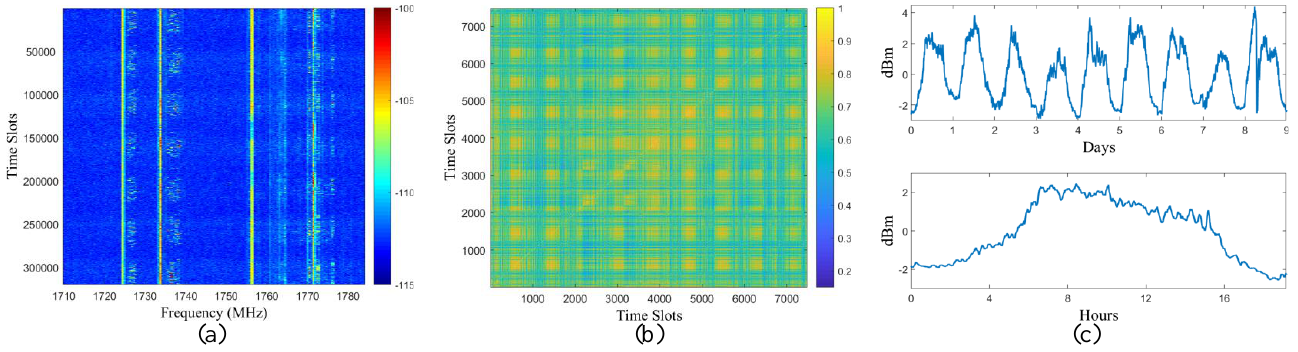
Figure 1. Periodic analysis of GSM1800 Uplink: ( a ) Raw spectrogram ( b ) Temporal-correlation heat map ( c ) Data detrending.